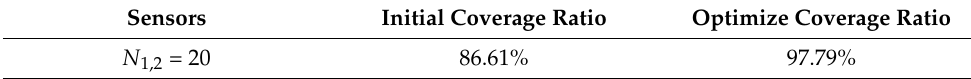
Table 17. Comparison of HWSN obstacle coverage optimization experimental results.